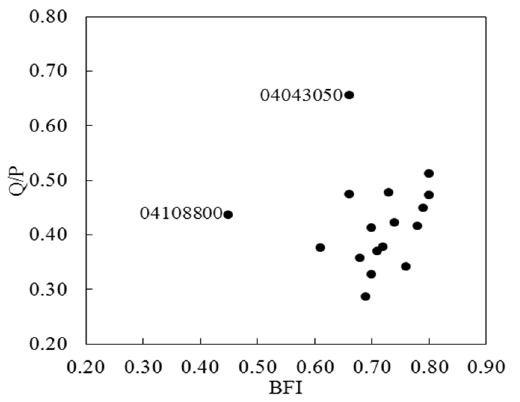
Figure 3. Relationship between runoff coefficient (Q/P) and baseflow index